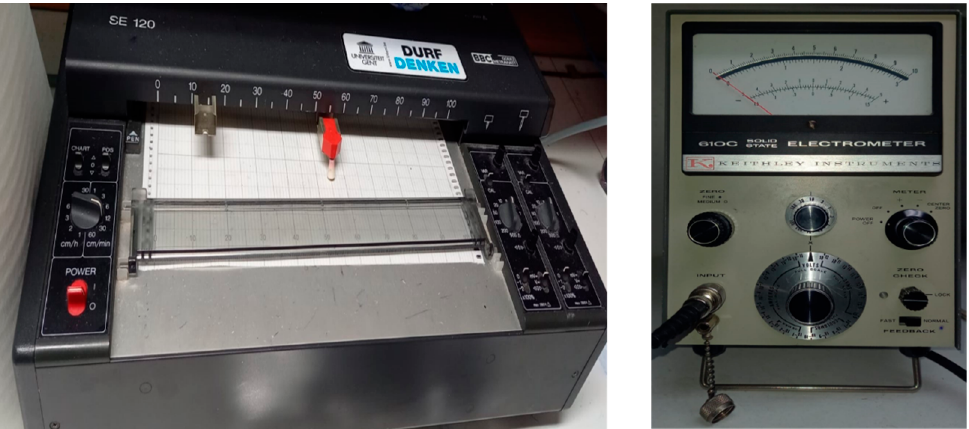
Figure 3. Standard plotter (METRAWATT SE 120 with KEITHLY’S Electrometer 610 C to measure and plotting of electrostatic behavior of Floorcoverings.